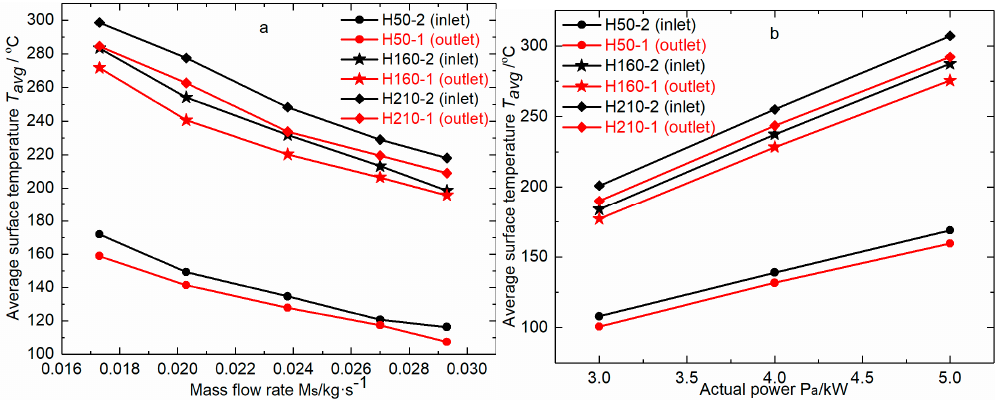
Figure 6. Average heating rod surface temperature versus ( a ) mass flow rate and ( b ) actual power.